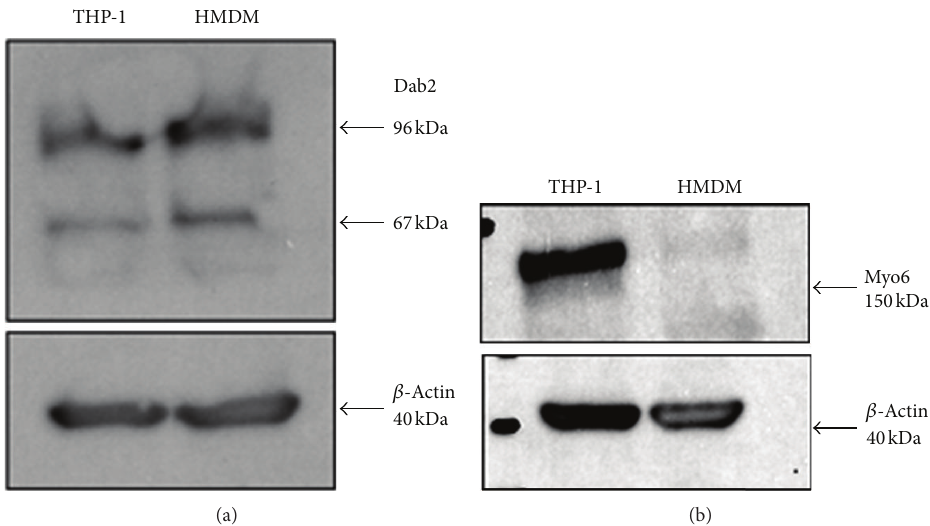
Figure 3: Expression of protein for Dab2 and Myo6 in THP-1 macrophages and HMDM. THP-1 macrophages or HMDM were lysed with RIPA buffer containing protease inhibitors. Protein expression was assessed by immunoblotting. (a) Dab2 (45 𝜇 g protein), (b) Myo6 (45mg protein) (Myo6 (H-215) and Dab2 (H-110) rabbit polyclonal IgG were from Santa Cruz Biotechnology Inc.). Results shown are representative of 3 separate experiments with THP-1 macrophages or cells from 2 individual donors for